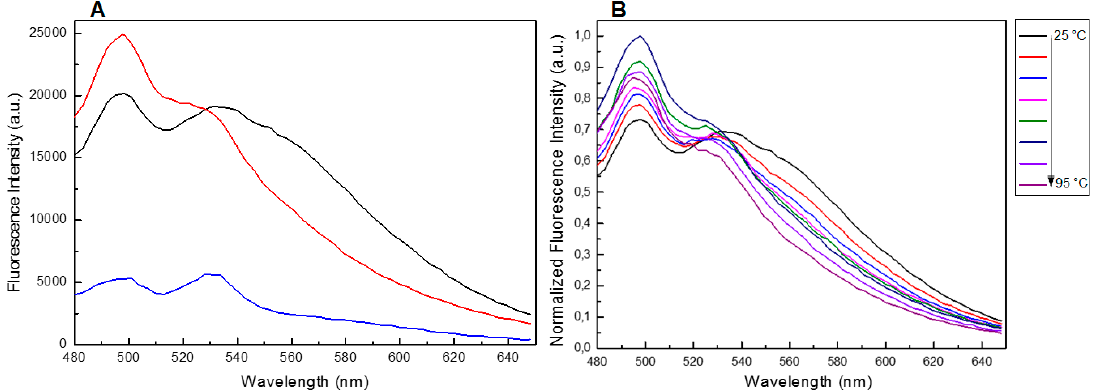
Figure 7. ( A ) Fluorescence spectra of the free DMAzo (blue line), 5’-DMAzo-TBA (red line) and 5’-DMAzo-T30695 (black line) at 25 °C in the wavelength range 480–650 nm, after excitation at 450 nm. ( B ) Temperature-dependent fluorescence spectra of the 5’-DMAzo-T30695, in the wavelength range 480–650 nm, after excitation at 450 nm. In all cases 5KWE was used as solvent.